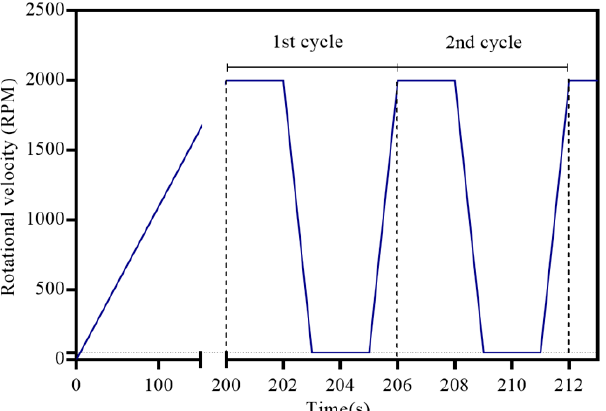
Figure 4. The rate of changes in rotational velocity of the disc during the mixing cycle (the disc is gradually spun to 2000 RPM).